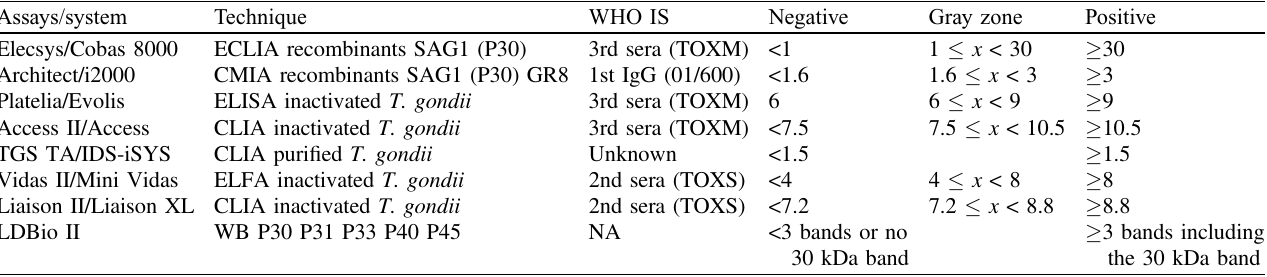
Table 1. IgG cut-off values recommended by the